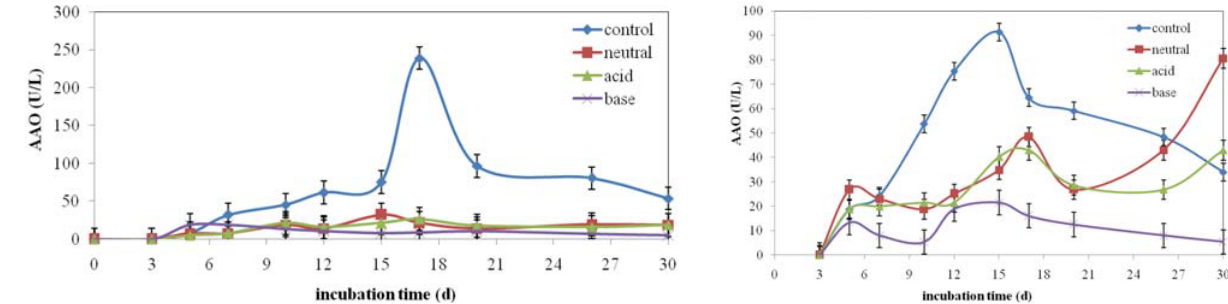
Figure 5. Variations of AAO activities depending on peach (left side) and cherry (right side) cultures. The values are the mean ± SD for experiments of three separate